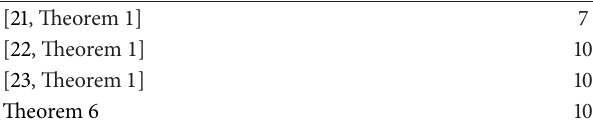
Table 2: The largest eligible value of time delay 𝑑(𝑘) ( 𝑑 𝑀𝑚